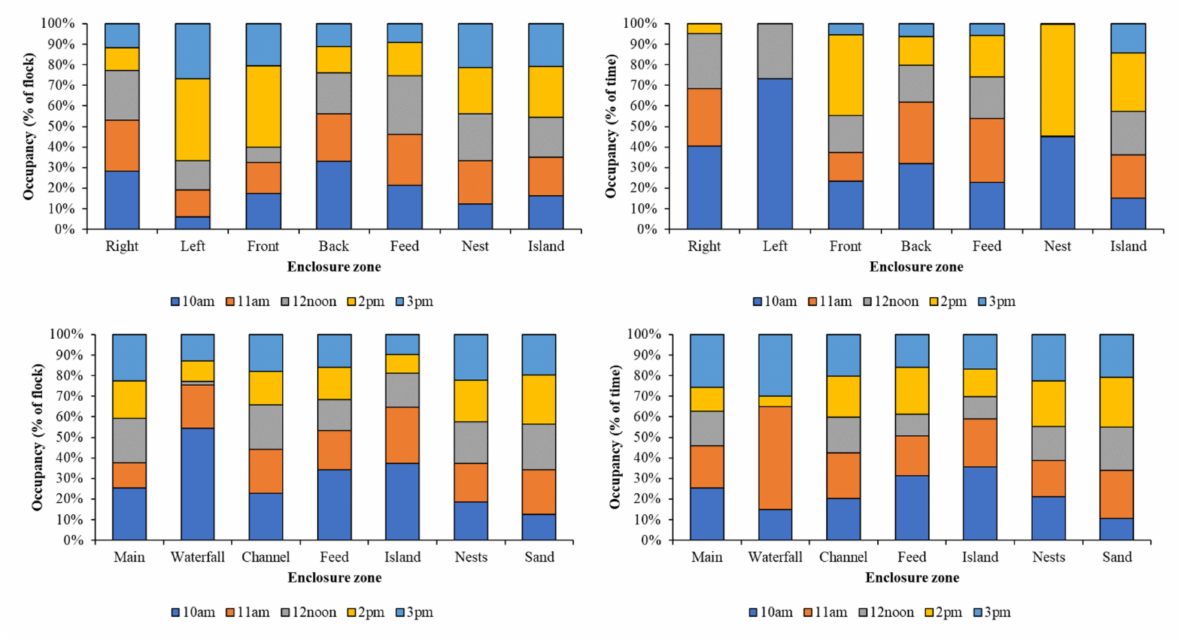
Figure 4. Occupancy of each enclosure zone for PZ group data ( top left ) and individual birds ( top right ) and BZ group data ( bottom left ) and individual birds ( bottom right ) for each observation time.